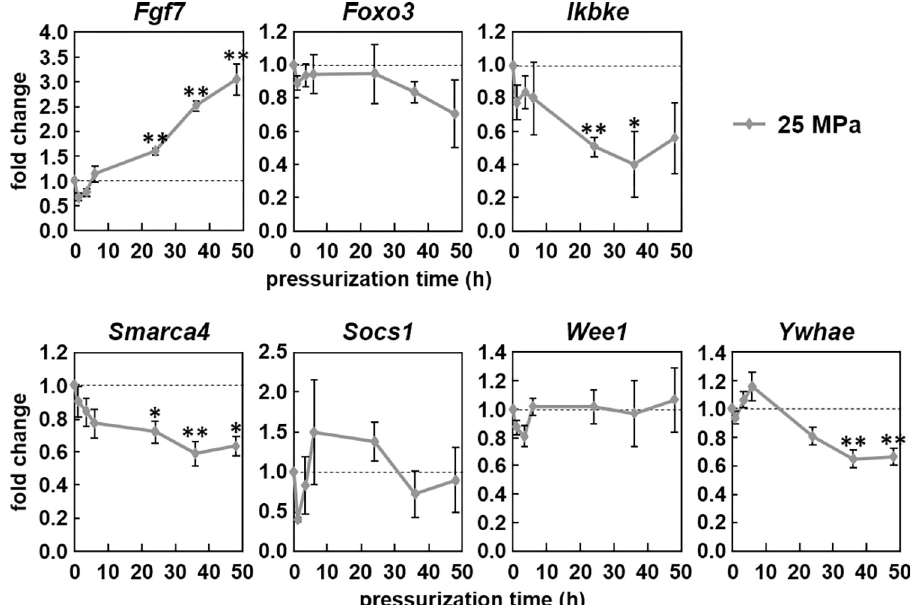
Fig 5. Expression of miR-155 targets under pressure. ATDC5 cells were pressurized for up to 48 h under 25 MPa. Fgf7 , Foxo3 , Ikbke , Smarca4 , Socs1 , Wee1 and Ywhae expression was then measured by real-time PCR. The graph shows the mean +/- SEM of at least three independent experiments. (one-way ANOVA followed by Tukey’s HSD, � : p < 0.05, �� :p < 0.01 pressurized vs. no